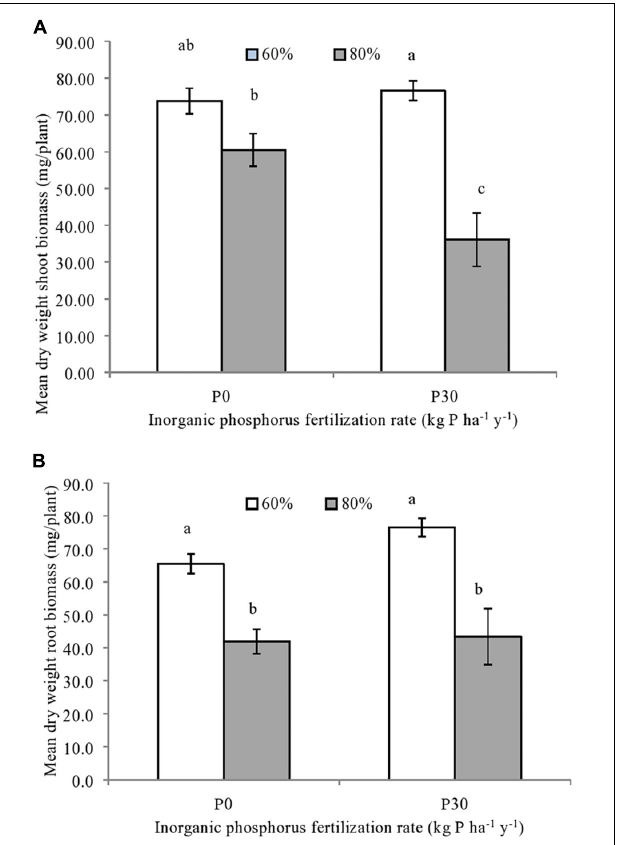
FIGURE 2 | (A) Mean shoot and (B) root biomass of individually sown spring wheat (T. aestivum) , grown within mesocosms using field soil sampled from a long-term inorganic phosphorus (P) fertilization experiment (44 years). Soil used was sampled from field plots that were either unfertilized (P0) ( n = 3) or fertilized at a rate of 30 kg P ha − 1 y − 1 (P30) ( n = 3). Soil water holding capacity was altered to 60% or 80% and was maintained within a growth chamber for four months. Error bars represent standard error of the mean. Significant differences in mean dry weight biomass are indicated by differences in letters ( p <